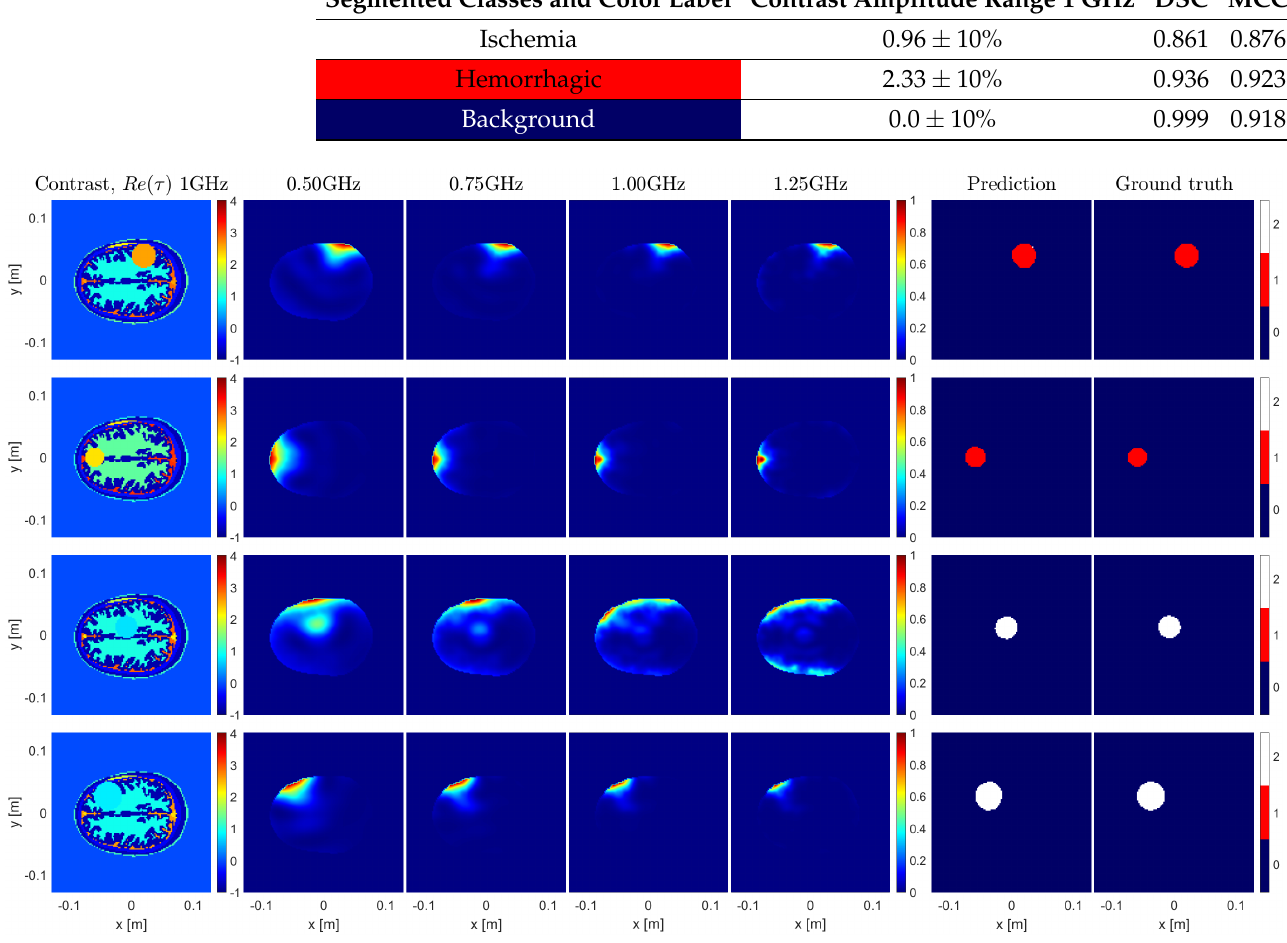
Table 3. Performance of the DL-MWI approach for stroke imaging and classification, split by kind of tissue.